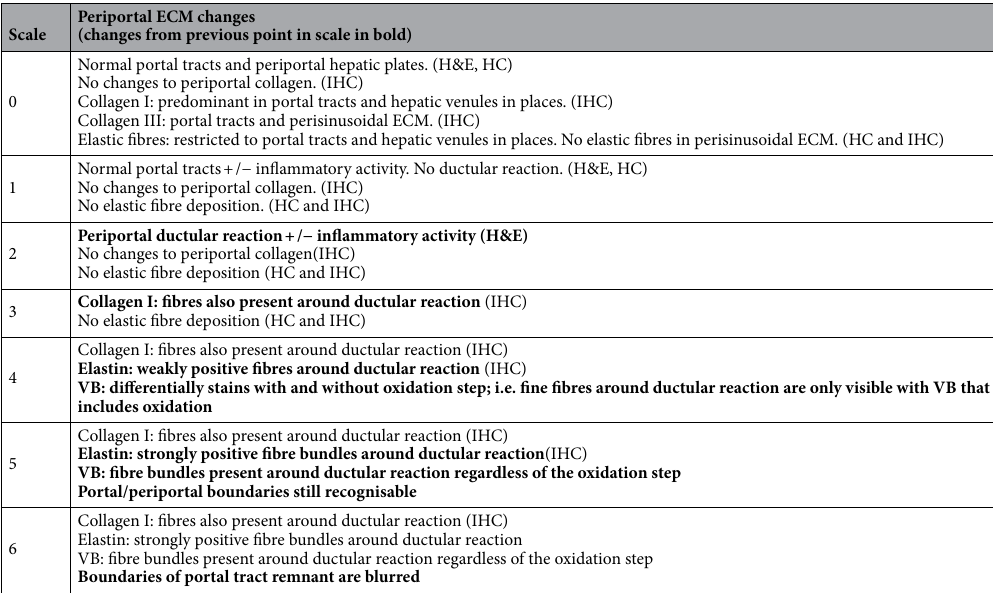
Periportal ECM changes Scale (changes from previous point in scale in bold) Normal portal tracts and periportal hepatic plates. (H&E, HC) No changes to periportal collagen. (IHC) Collagen I: predominant in portal tracts and hepatic venules in places. (IHC) 0 Collagen III: portal tracts and perisinusoidal ECM.